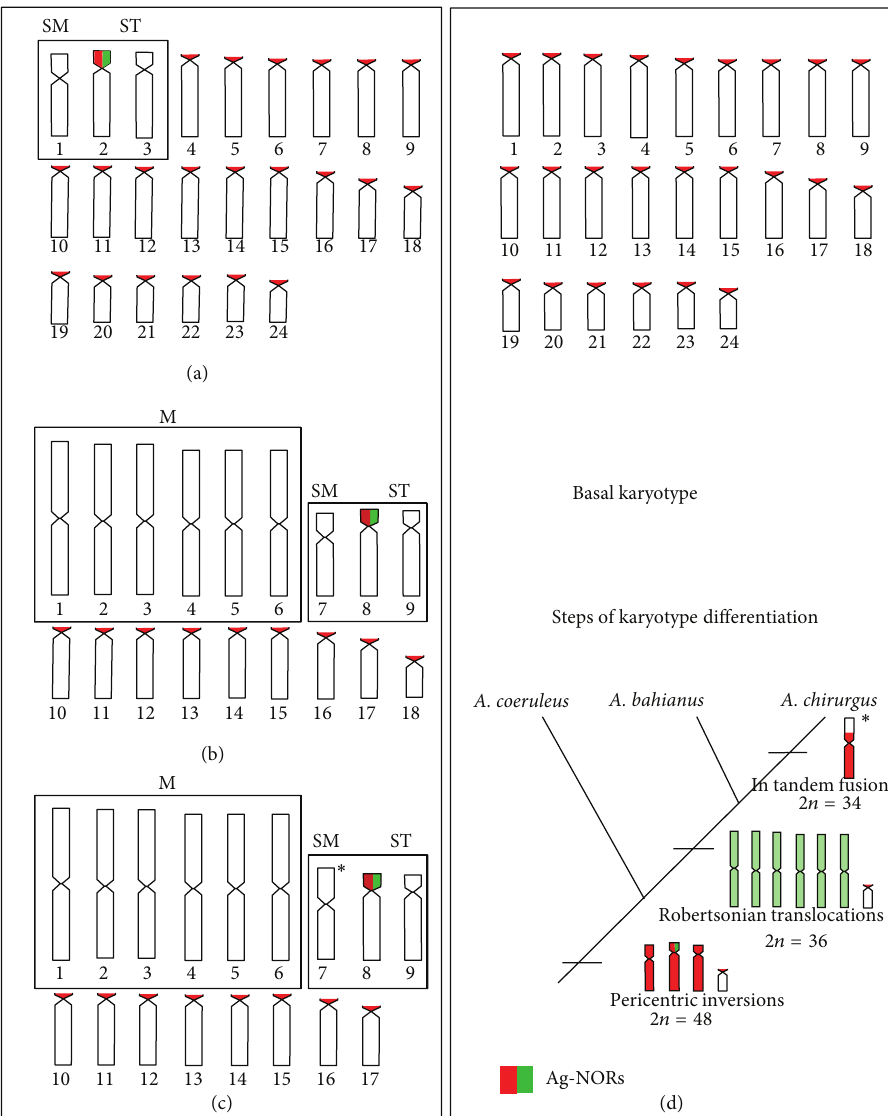
Figure 3: Idiograms of chromosomes sets of Acanthurus coeruleus (a), A. bahianus (b), and A. chirurgus (c) showing the most conspicuous shared cytogenetic traits in boxes. In (d), the basal karyotype of Perciformes ( 2𝑛 = 48 a) and a phylogenetic hypothesis based on sequential chromosomal rearrangements inferred in the three Acanthurus